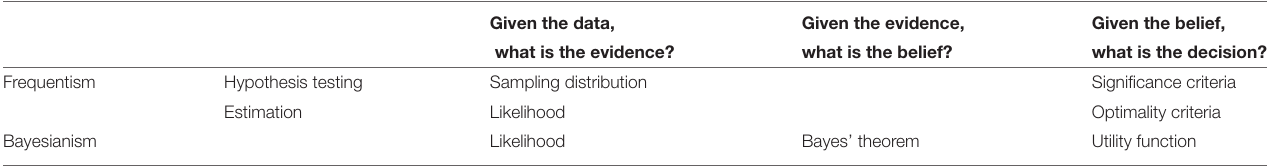
TABLE 1 | Comparison of the different concepts used in frequentism and Bayesianism.